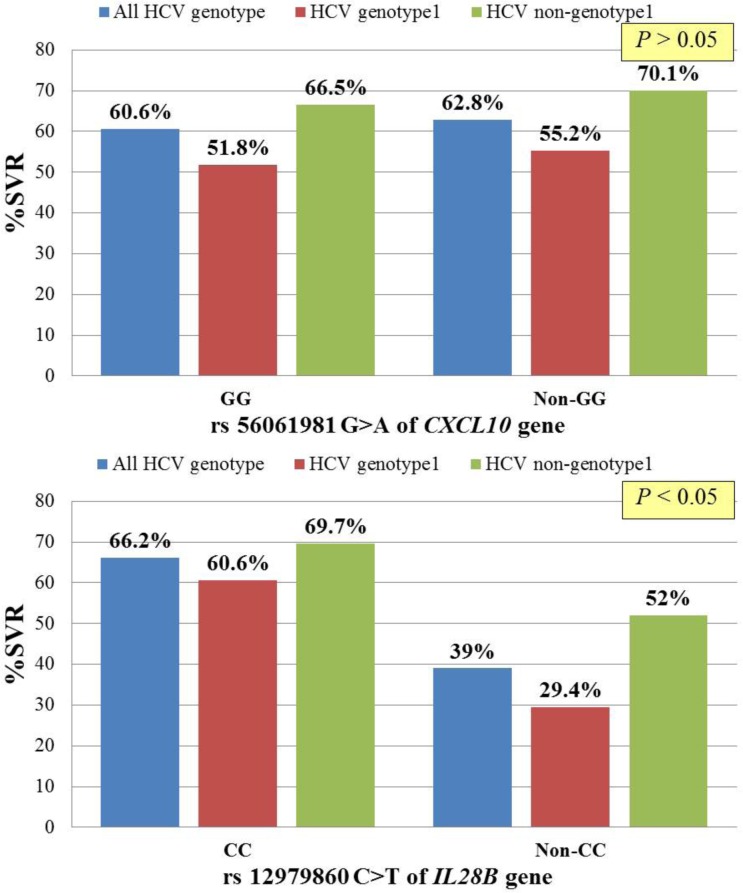

CXCL10 rs56061981, IL28B rs12979860 polymorphisms according to sustained virological response (SVR) in patients with CHC infection.